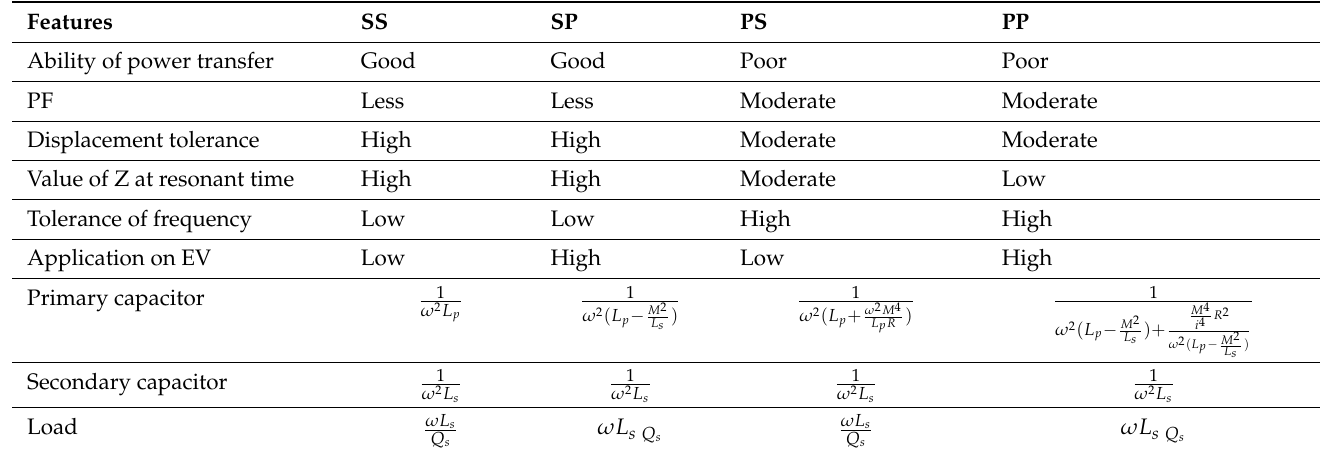
Table 1. Advantages and features of the compensation network.